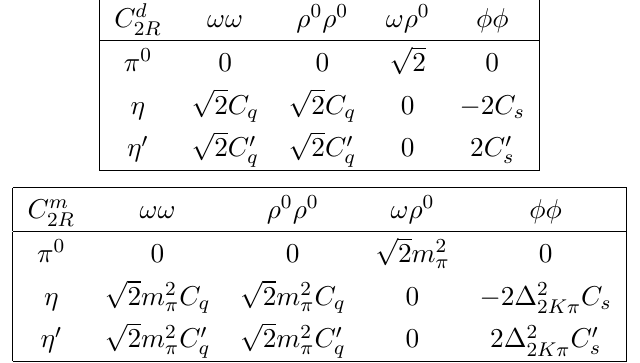
(left) and C m (right) for the couplings between di(cid:11)erent mesons. 1 R 1 R